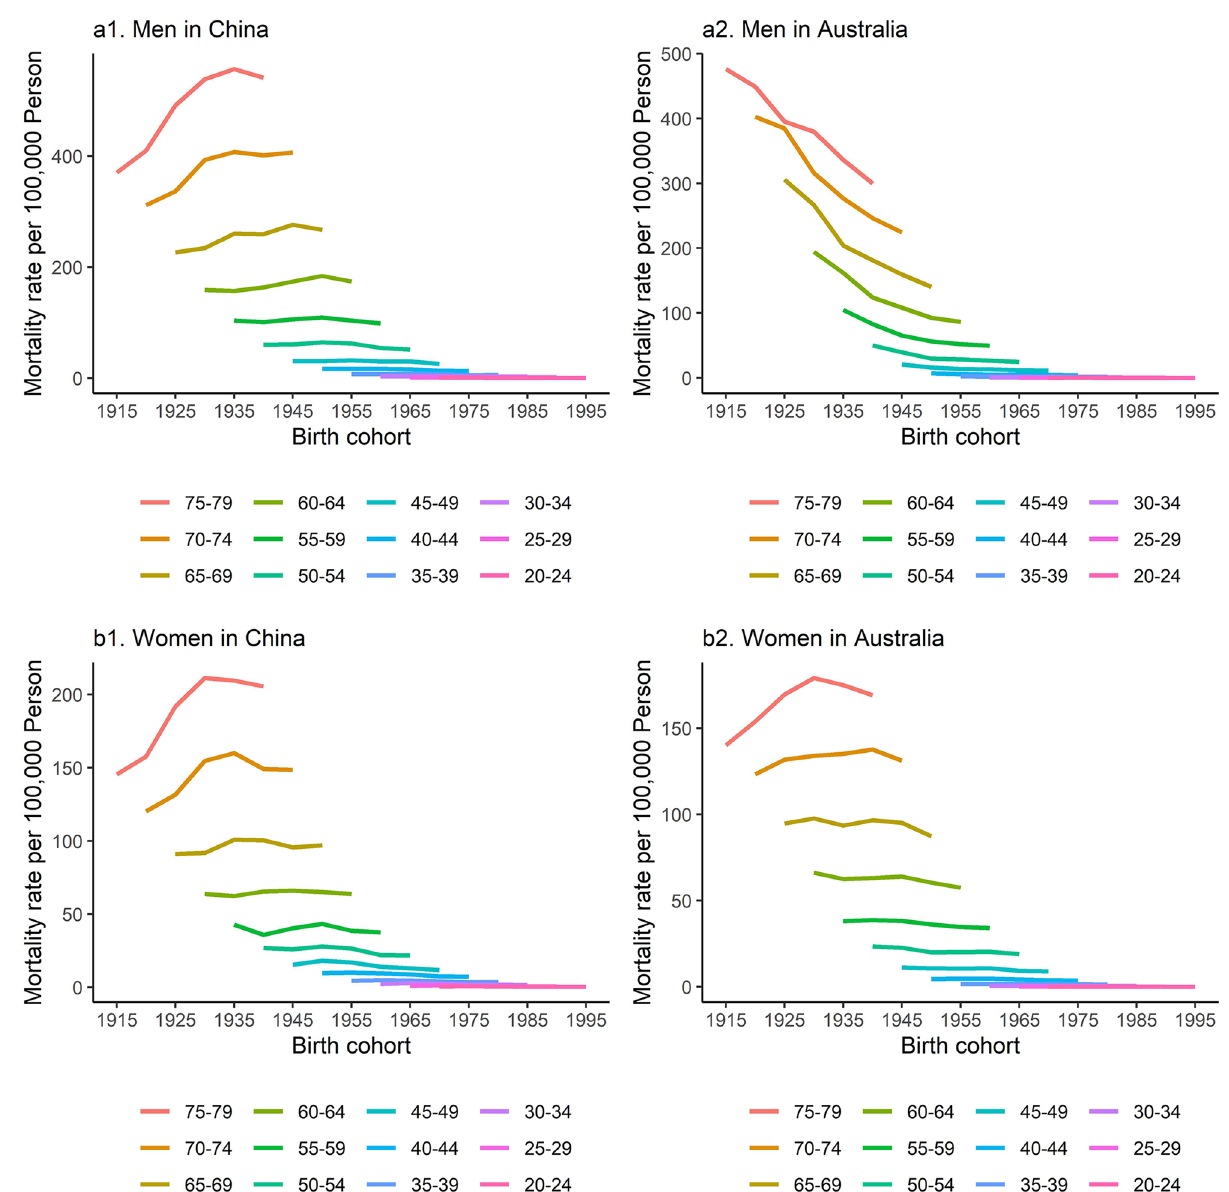
Figure 3. Cohort-specific mortality rates of lung cancer by age and sex in China and Australia, 1990 to 2019. Data of lung cancer mortality were grouped into 17 successive birth cohorts which include those born between 1913–1917 and 1993–1997, and 12 age groups between 20–24 and 75–79. ( a1 ) Shows that lung cancer mortality rate increased over birth cohorts among Chinese men aged between 60 and 79, indicating a higher rate in more recent birth cohorts among these age groups. On the contrary, there was a decreasing trend over birth cohorts among Chinese men aged between 20 and 59, indicating a lower mortality rate in more recent birth cohorts in these relatively young age groups. ( a2 ) Shows that lung cancer mortality rates decreased over birth cohorts in all age groups of Australian men. This suggests a lower risk of lung cancer death in more recent birth cohorts across all ages. ( b1 ) Shows that the trend of age-specific lung cancer mortality rates with birth cohort in Chinese women was similar to that in Chinese men. ( b2 ) Shows that Australian women aged between 70 and 79 have experienced an increasing trend over birth cohorts, while those aged between 20 and 69 have experienced a decreasing trend over birth cohorts (P < 0.001 for CI 0.90, 0.96]). The cohort effect showed that Chinese men born after 1955 had a favorable trend of LCM rate associated with smoking (RR from 0.98 [95% CI 0.96, 1.01] to 0.69 [95% CI 0.43, 1.08] between the birth cohort of 1955 and 1985), while the rate associated with smoking among Australian men continued improving over the birth cohort (RR from 3.10 [95% CI 2.94, 3.25] to 0.34 [95% CI 0.12, 0.95] during the entire study cohort) . LCM rate attributable to smoking was consistently higher among Australian women than that among Chinese women across all age groups. LCM rate attributable to smoking constantly declined among Australian women over the